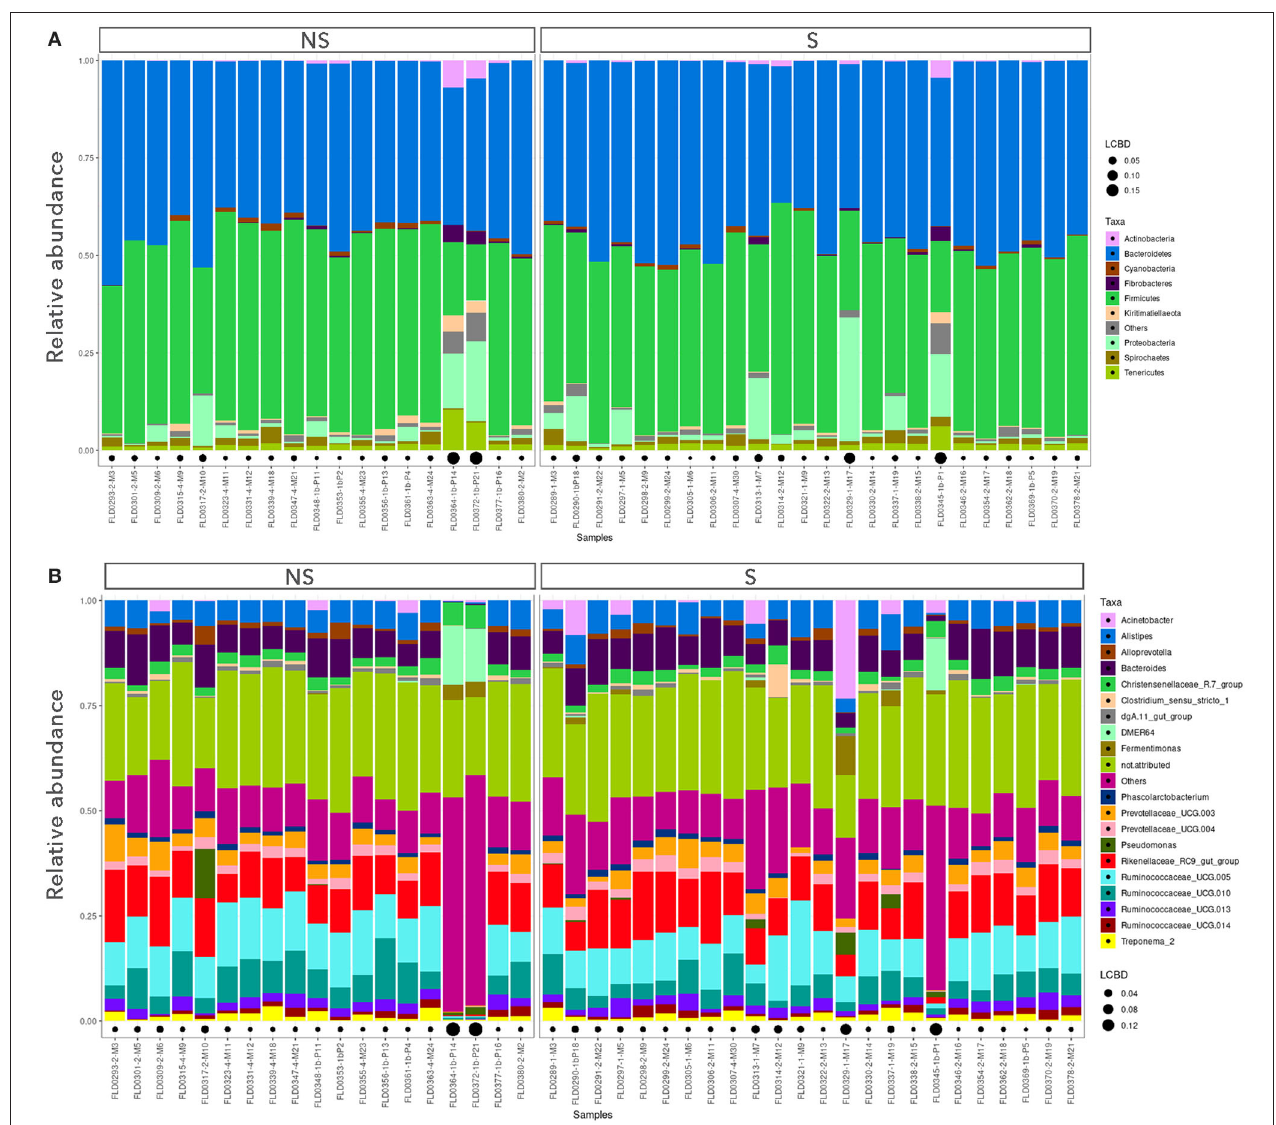
FIGURE 1 | Taxonomic profiles of the fecal bacteria from enterohemorrhagic Escherichia coli (EHEC) O157:H7 shedders (S) and non-shedders (NS). (A) Bar plot representation of relative proportion of the nine major phyla in the fecal samples. (B) Bar plot representation of relative proportion of the 20 major genera in the fecal samples. Only data from young bulls were used for this analysis. Black points size is proportional to the local contribution to beta diversity for each